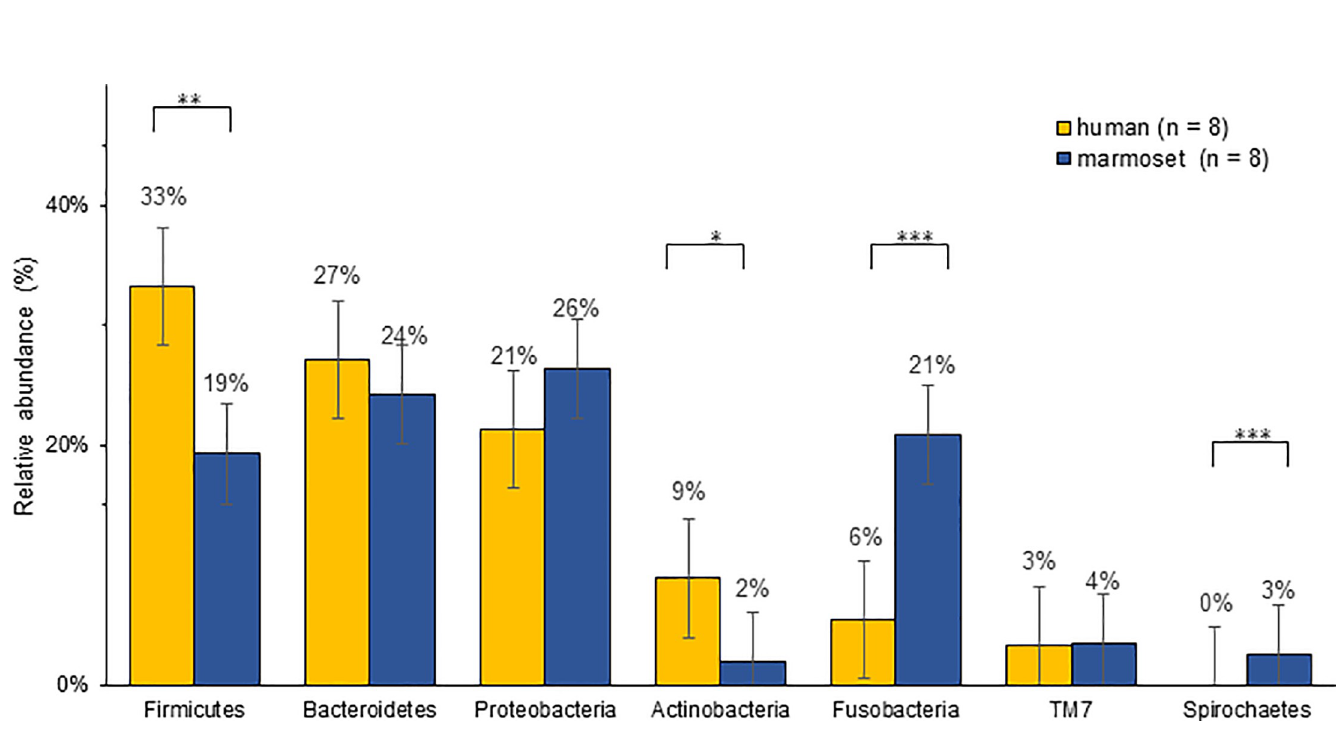
PLOS ONE | https://doi.org/10.1371/journal.pone.0207560 February 7,